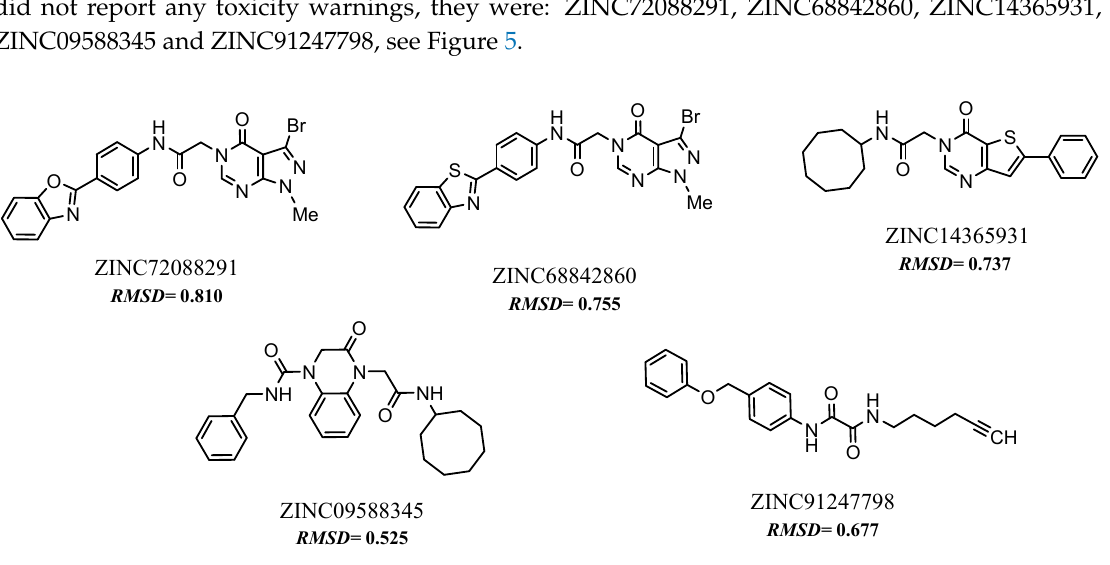
Figure 5. 2D Structures and their respective values Root Mean Square Deviation (RMSD).